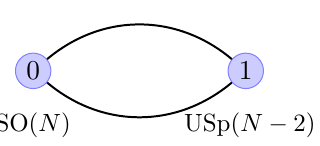
Figure 7. On the left, the quiver diagram for C , where the red line represents the orientifold projection. On the right, the linear ‘unoriented’ quiver for the theory after the orientifold [8].